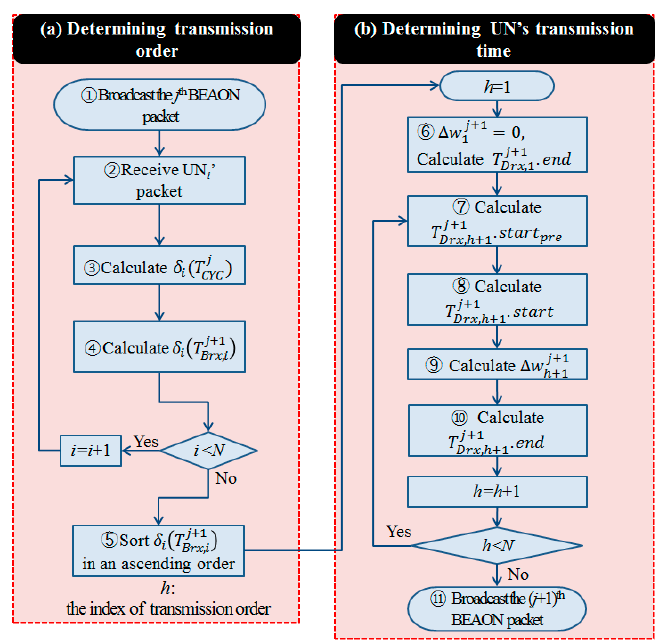
Figure 5. Flow chart for the transmission scheduling algorithm of the APD-TDMA.